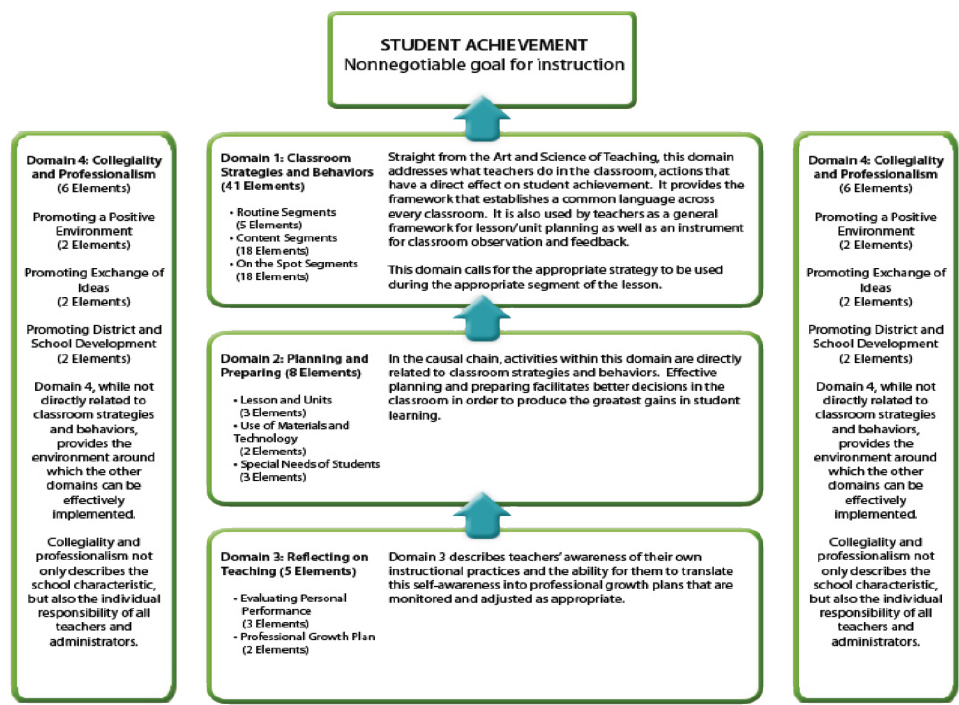
Figure 1. Four Domains of the Marzano Teacher Evaluation Model (Source: Marzano Center https://www.learningsciences.com/wp-content/uploads/2020/06/The-Marzano-Teacher-Evalua- tion-Model.pdf (accessed on 1 March 2023)).